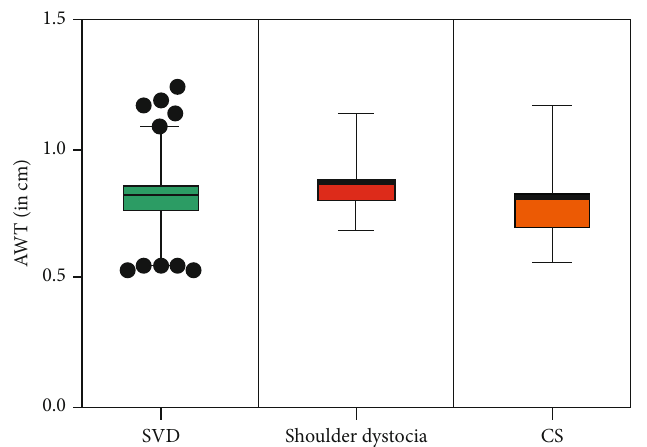
Figure 3: Abdominal wall thickness (AWT) by intrapartum outcome (spontaneous vaginal delivery (SVD), shoulder dystocia, and Caesarean section